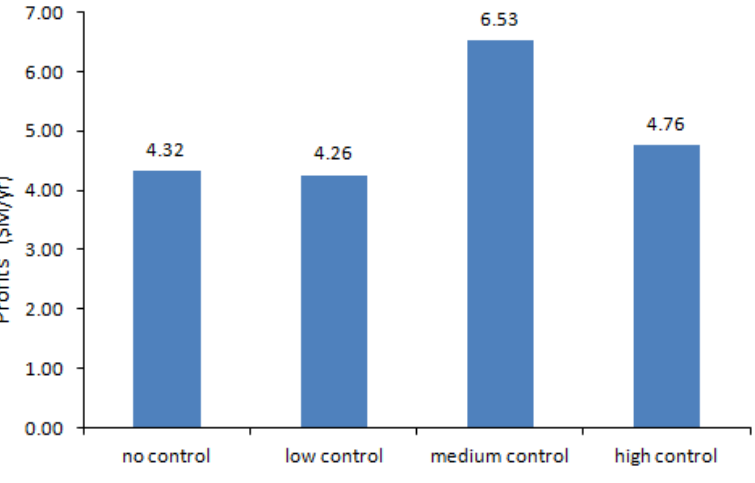
Figure 4. SWNT exposure results from NLP method.